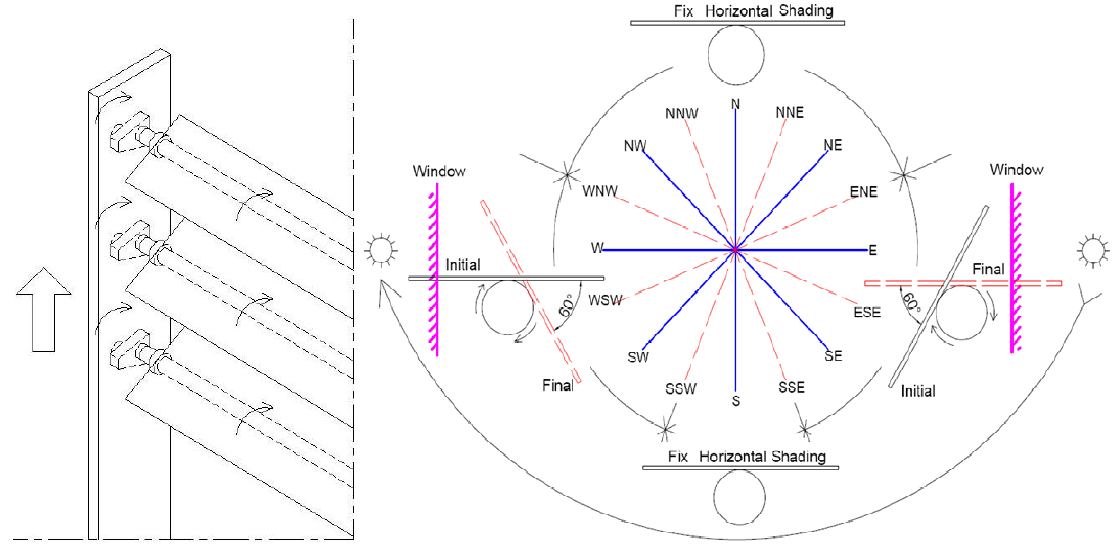
Figure 3. The driving and rotating mechanisms of